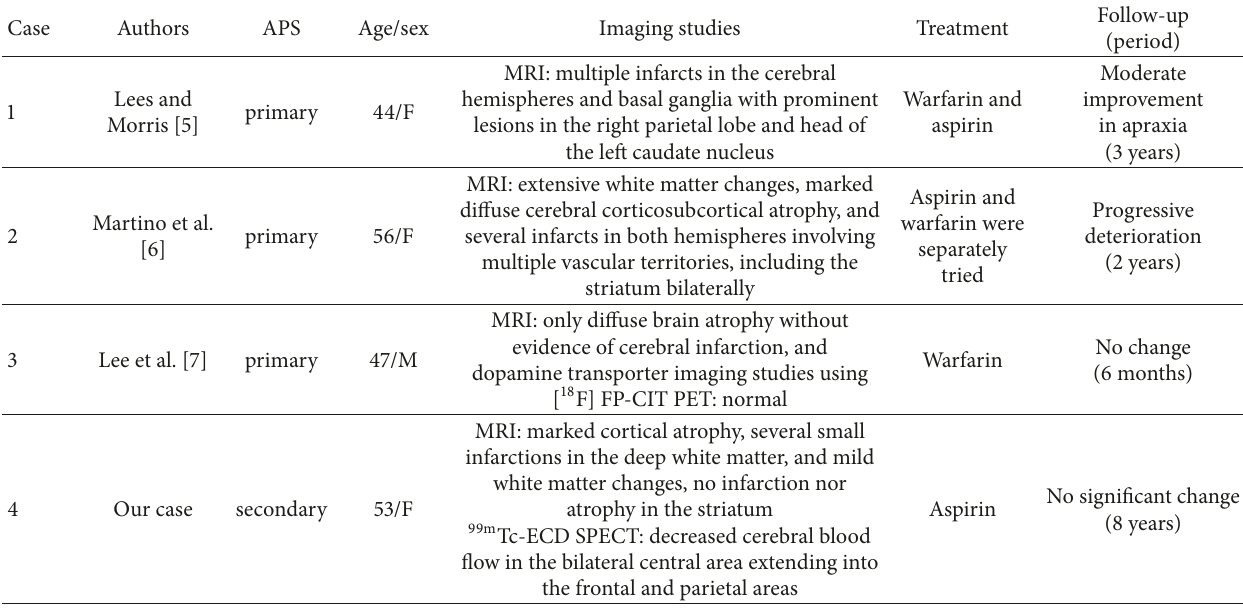
Table 2: Reported cases of corticobasal syndrome associated with antiphospholipid